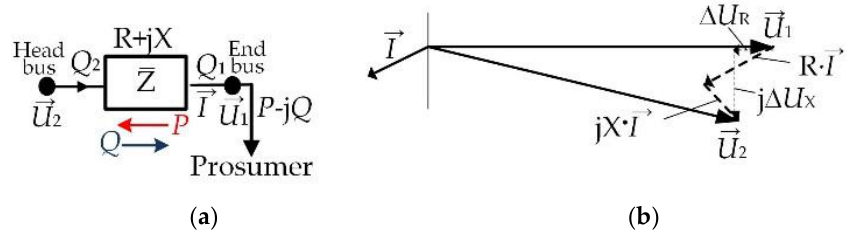
Figure 3. Overview of a feeder segment with back-up active power supply: ( a ) Equivalent circuit; ( b ) Phasor diagram.